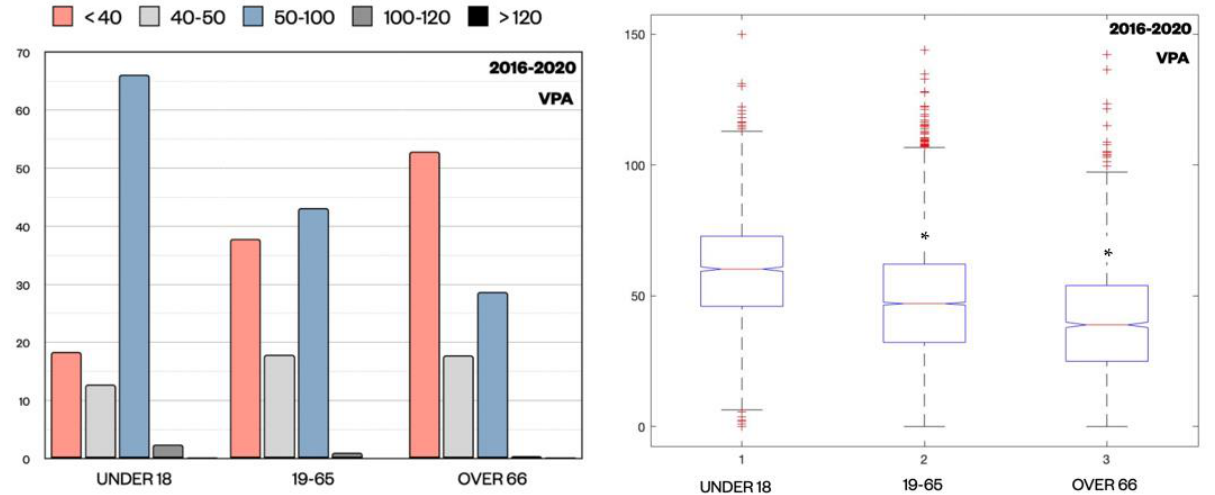
Figure 5. Distribution of VPA Cp ( µ g/mL) expressed as percentage for each subpopulation divided by ranges (< 40, 40 – 50, 50 – 100, 100 – 120, >120) and by age groups (under 18, 19 – 65, over 66). z-test revealed a statistically significant difference in Cp distribution proportions across the age groups, in particular for samples < 40 µ g/mL and between 50 µ g/mL and 100 µ g/mL. The median value of VPA ( µ g/mL) for each age group is also shown. * p < 0.001 compared to the group under 18 by Kruskal – Wallis test. (+ outliers samples are marked).